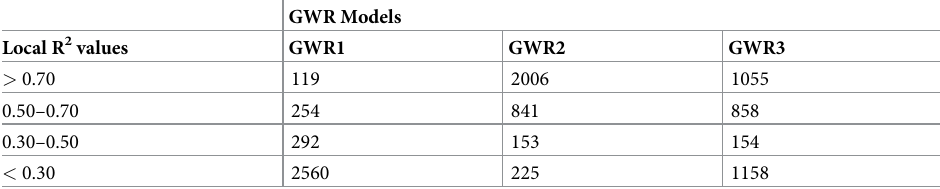
Table 5. Total cases of TB classified according to the different classes of local R 2